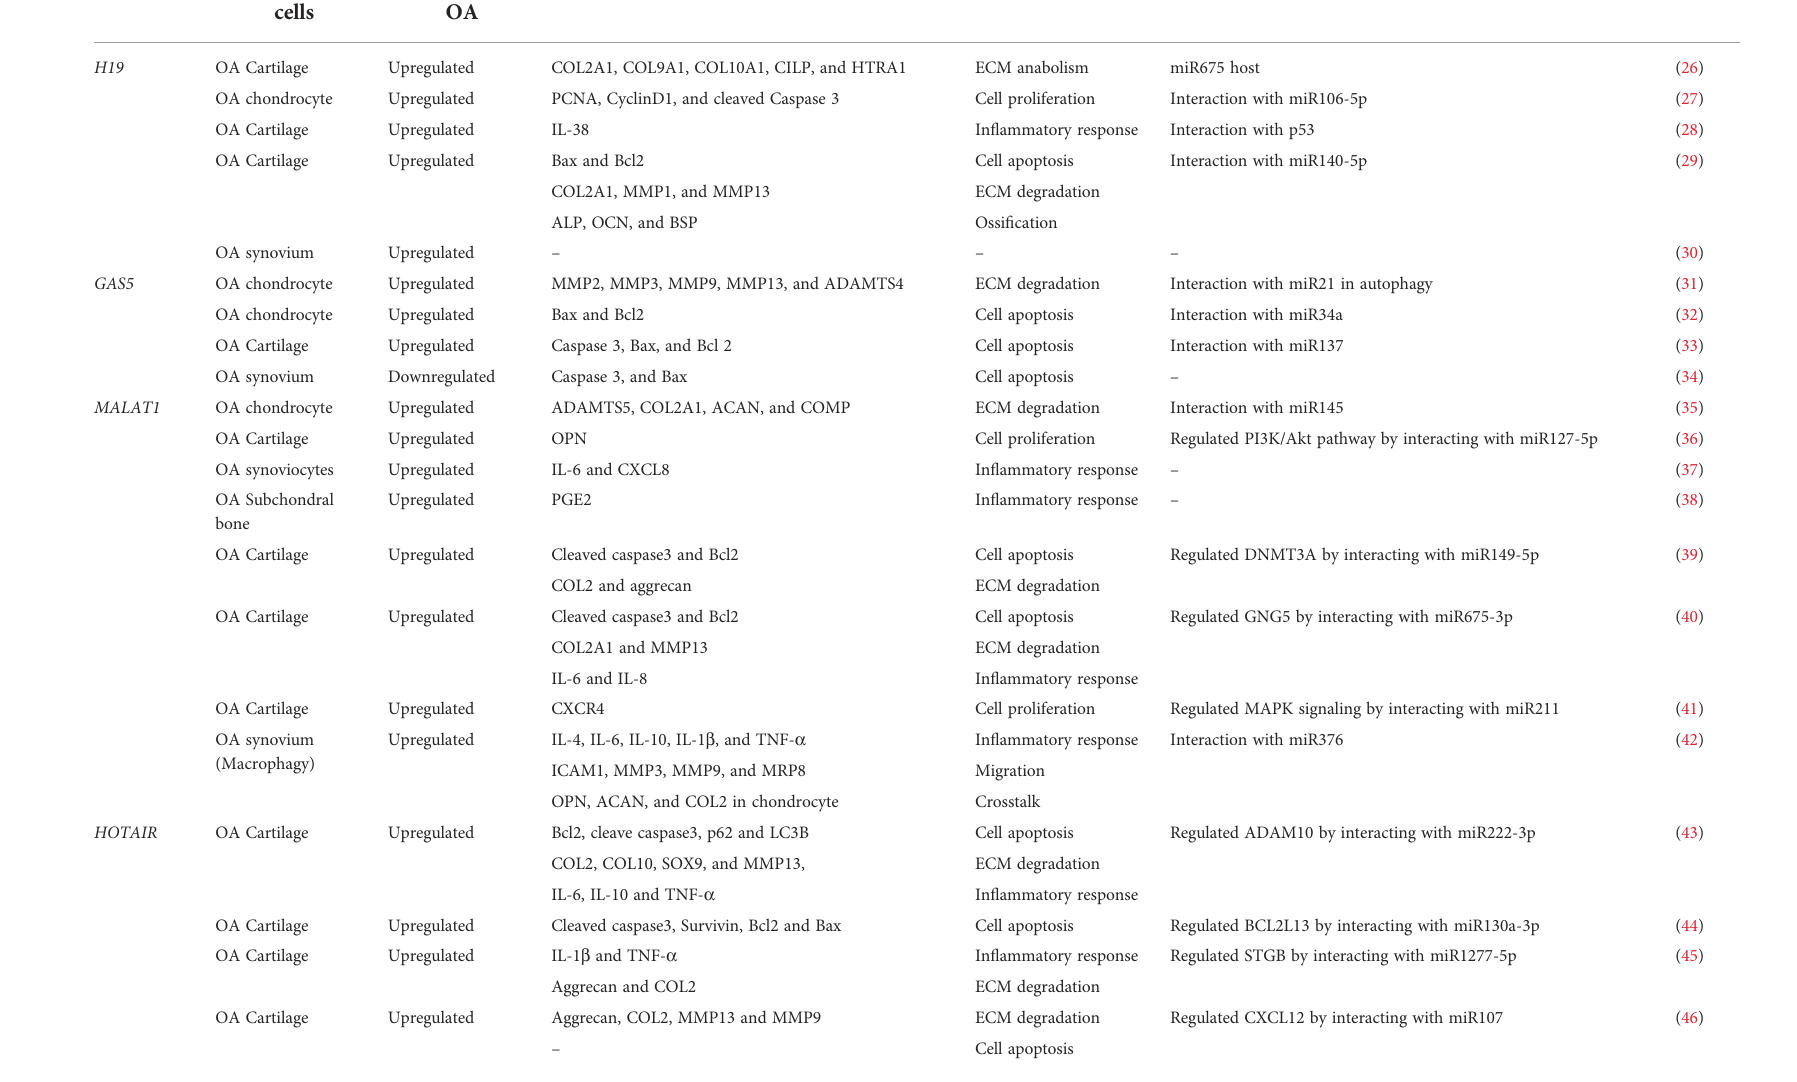
TABLE 1 The dysregulated lncRNA in clinical OA